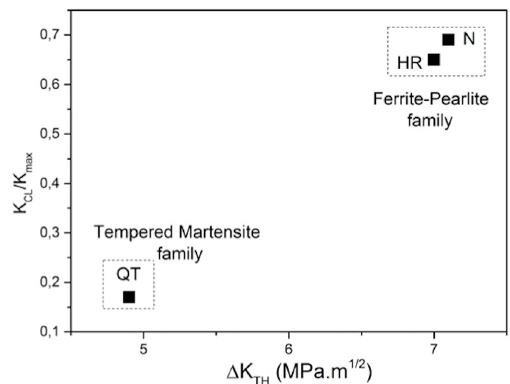
Figure 6. Closure measurements in function of the threshold. HR = hot-rolled; N = normalized; QT = quenched and tempered.